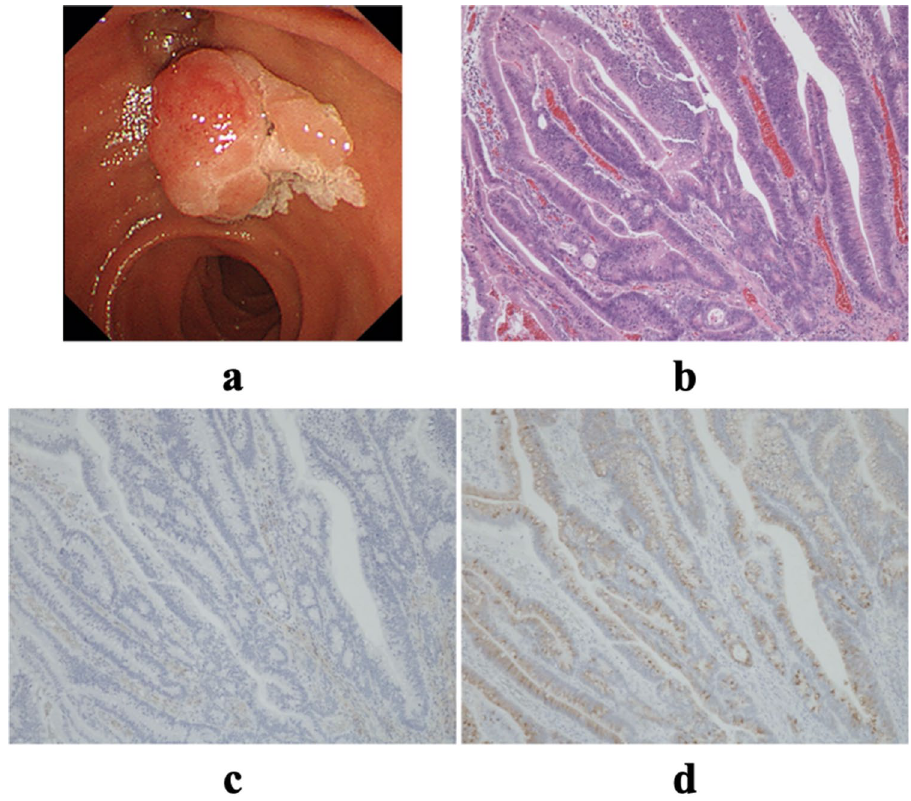
Figure 3. Characteristics of intestinal-type tumors. ( a ) Endoscopic image. ( b ) Hematoxylin–eosin staining of the tumor (× 40). ( c ) MUC1 expression in the tumor (× 40); ( d ) MUC2 expression in the tumor (× 40). MUC1, pancreatic-type mucin; MUC2, intestinal-type